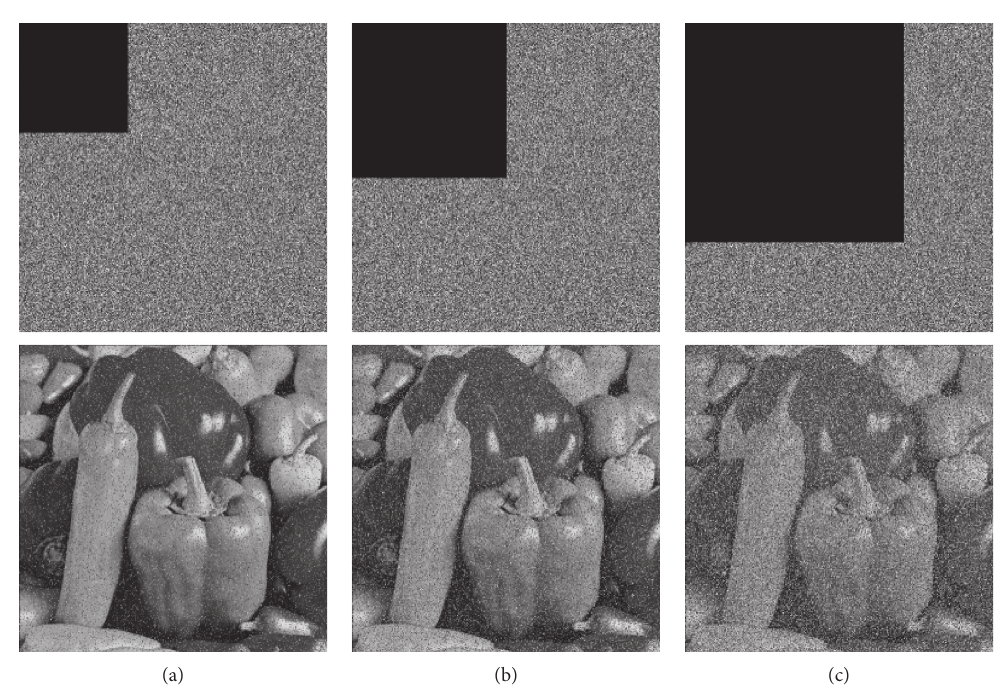
Figure 14: Cropping attack analysis. (a) Missing 12.5% of data; (b) missing 25% of data; (c) missing 50% of